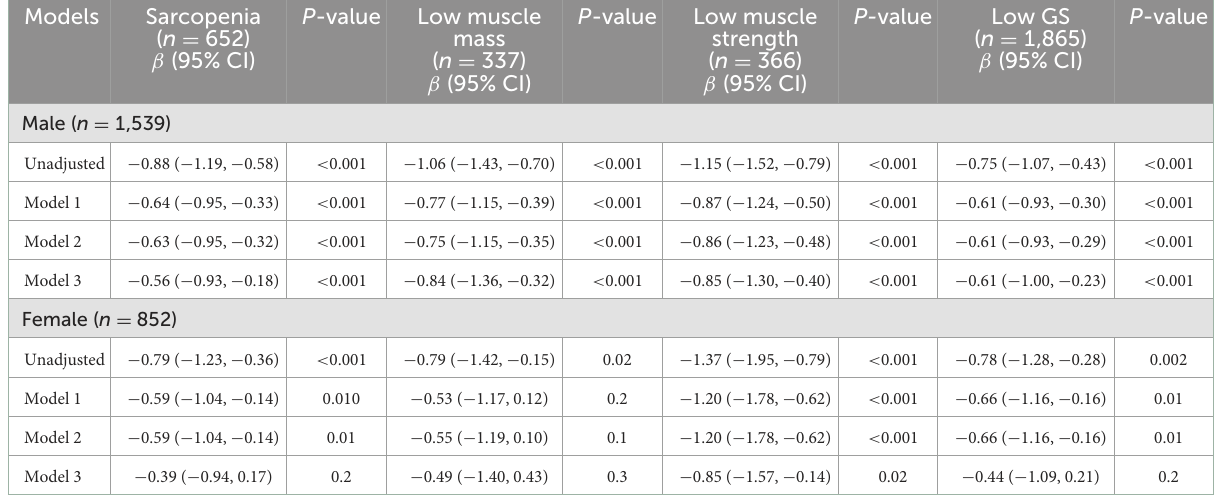
TABLE 3 Multivariate linear regression model of sarcopenia and cognitive function.